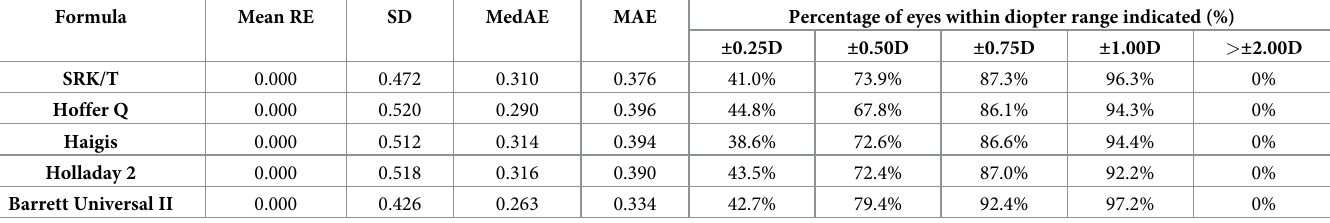
Table 2. Clinical outcomes of refractive prediction error and absolute error and among the five IOL formulas after adjusting the mean refractive prediction error to zero (n = 324). Formula